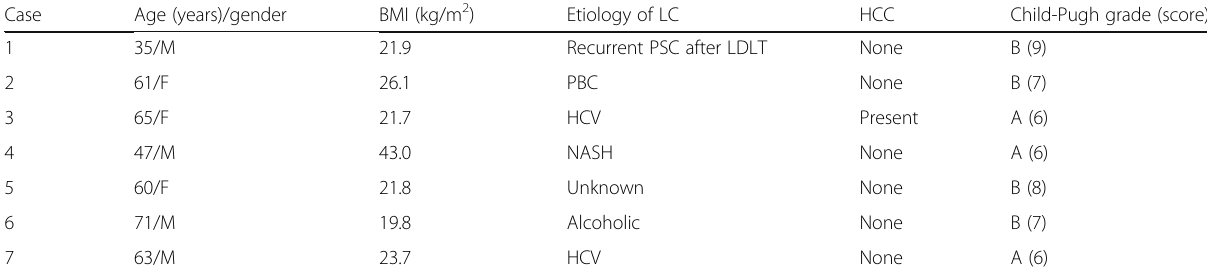
Table 1 Patient characteristics Case